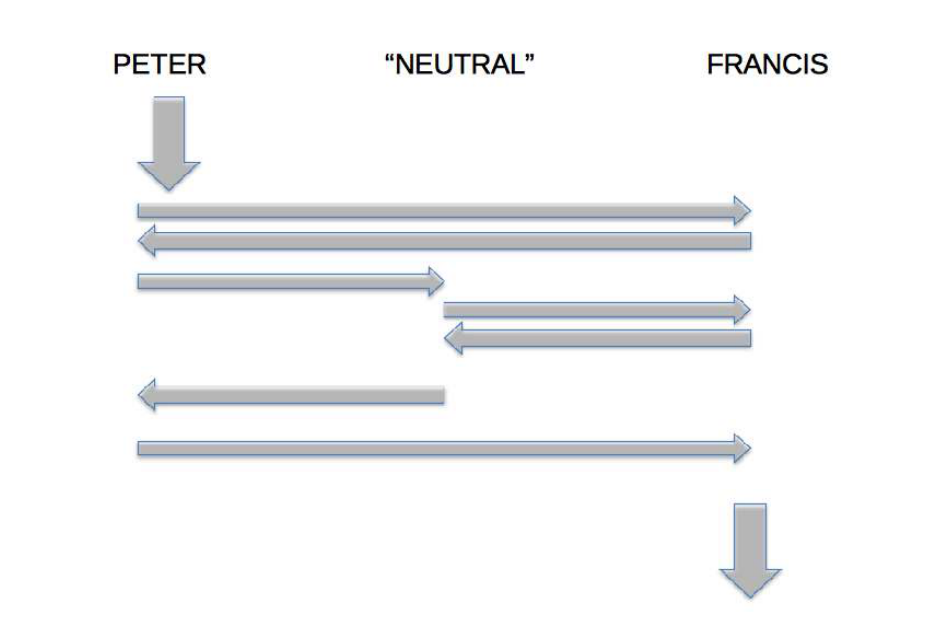
There is a constant flow between the minds of the twin brothers, although at the end of this part Peter disappears, leaving Francis to fend for himself.